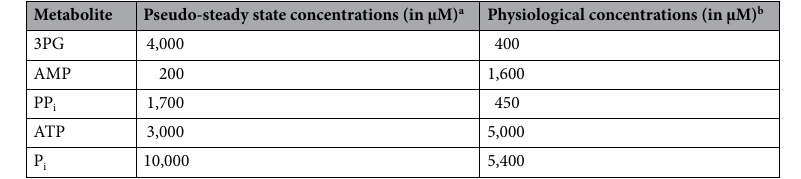
Table 3. Metabolite concentrations used in the models. a See Tables 1, 2 of Ref. 8 . b See Table 3 of Ref. 8 .